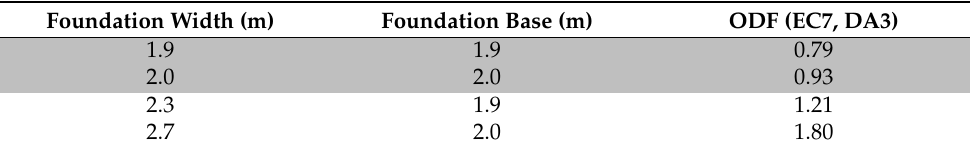
Table 2. The ULS analysis results for the selected final designs from [1].